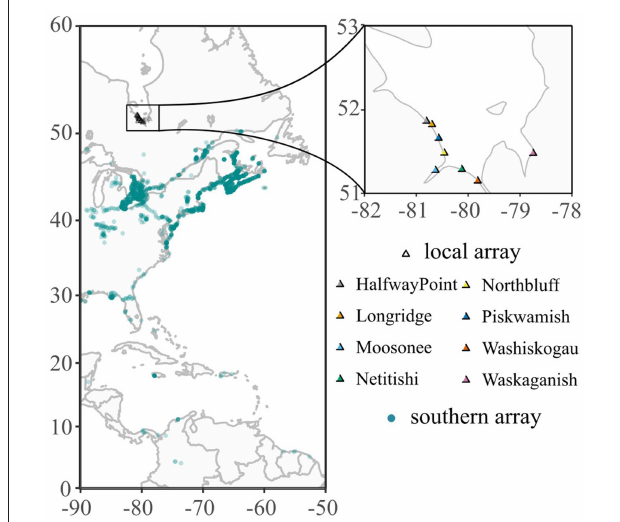
FIGURE 1 | Locations of Motus Wildlife Tracking System automated VHF radio telemetry receiver stations used to track shorebirds during stopover along the southwestern coast of James Bay, Ontario, Canada, and during southbound migration. Towers mapped were active in at least 1 year between 2014 and 2017. Darker blue dots indicate multiple towers in close proximity. One tower at Asunción Bay, Paraguay, is not shown in the figure.